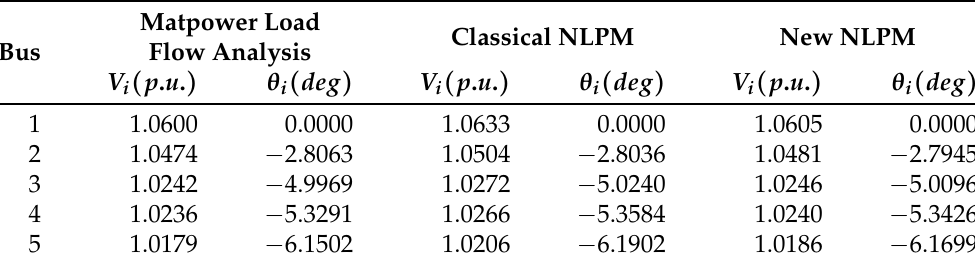
Table 3. Estimated values of ˆ x considering bad data